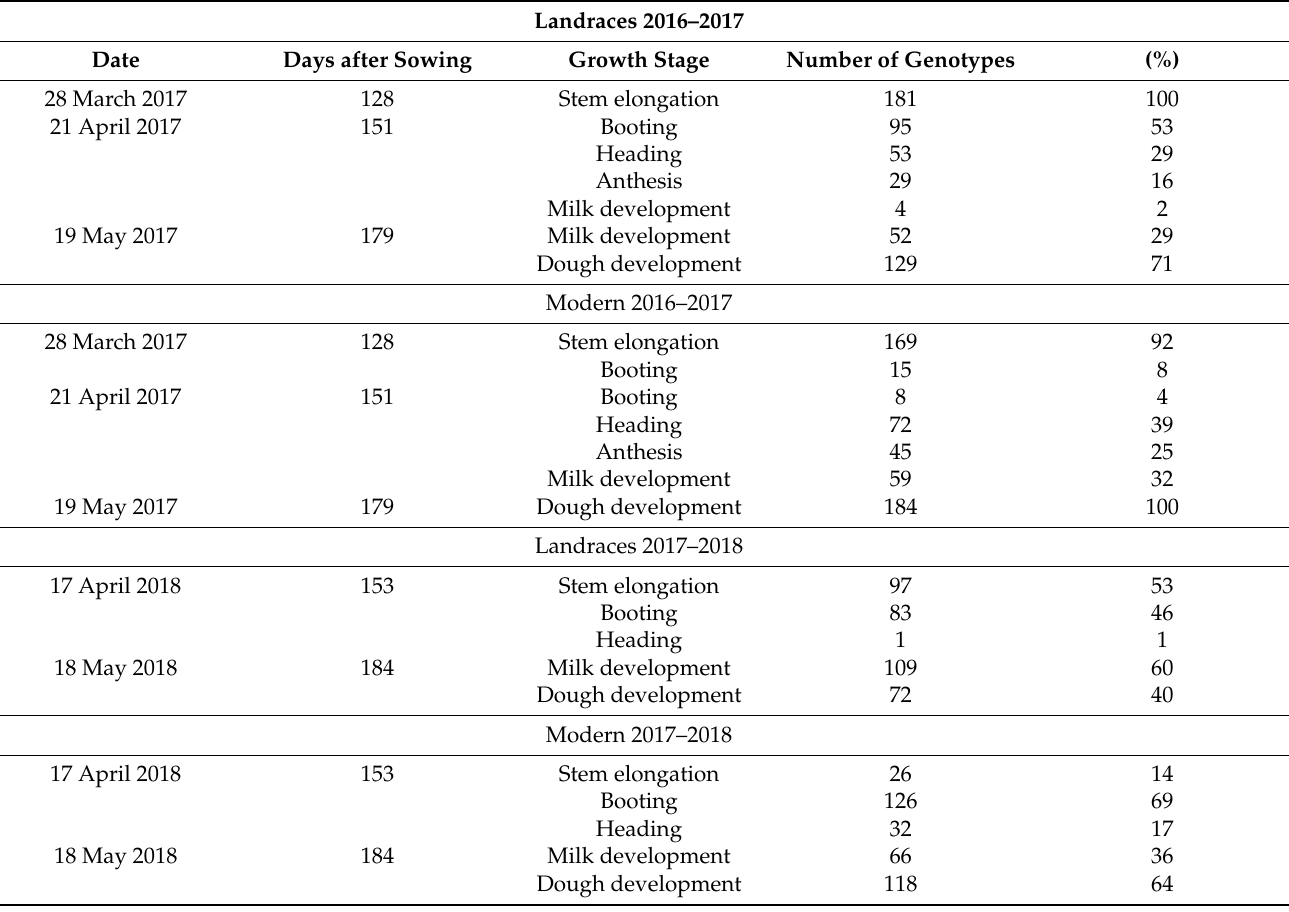
Figure 1. Field view of both collection sets, landraces and modern cultivars, at each image acquisition date of the growing season 2016–2017. DAS, days after sowing. Table 1. Number and percentage of genotypes showing each growth stage at each image acquisition